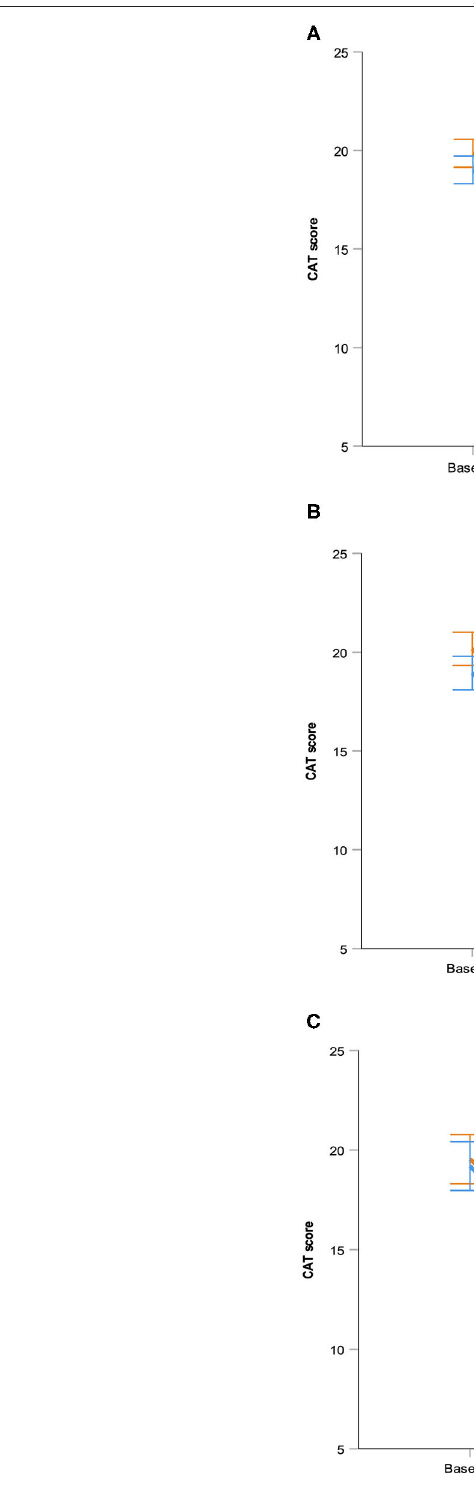
Frontiers in Medicine |